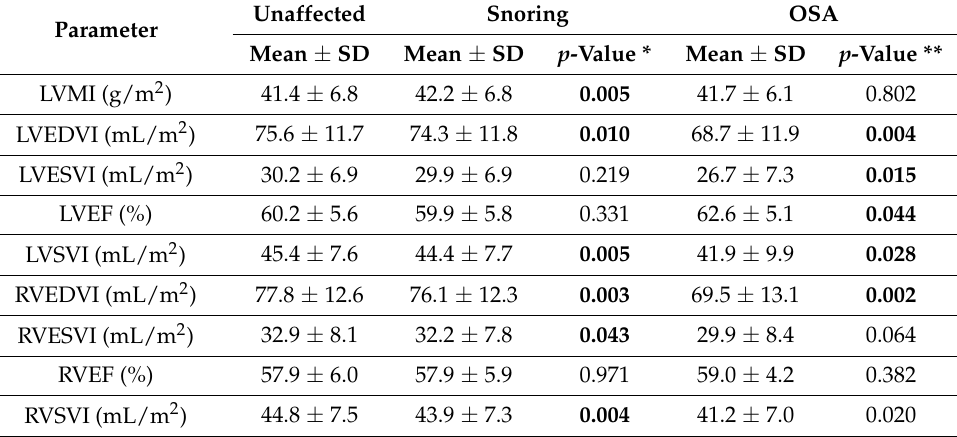
Table 2. Descriptive statistics of left and right ventricular cardiac parameters snoring vs. unaffected * and OSA vs. unaffected ** in female subjects. Significant results are marked in bold. Reported values are left ventricular mass index (LVMI), end-diastolic volume index (LVEDVI), end-systolic volume index (LVESVI), ejection fraction (LVEF) and stroke volume index (LVSVI) and right ventricular end-diastolic volume index (RVEDVI), end-systolic volume index (RVESVI), ejection fraction (RVEF) and stroke volume index